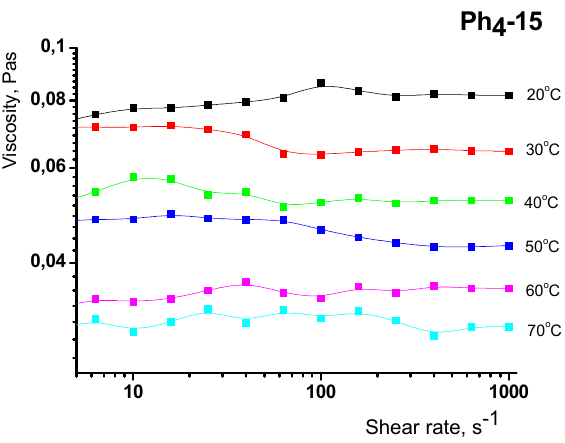
Figure 8. Flow curves of star-shaped Ph 4 -15 polymer at 20, 30, 40, 50, 60, and 70 °C. The viscosity temperature dependencies in Arrhenius equation coordinates (Figure 9) were plotted.